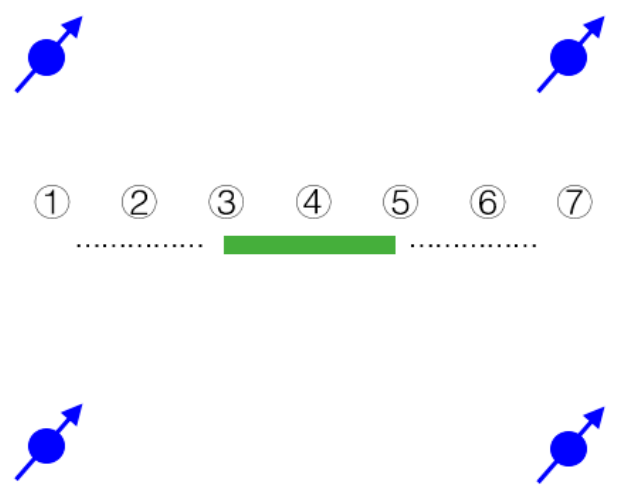
Figure 10. Mixed five-spot well pattern of vertical-injectors and horizontal producer ( ① – ⑦ show the code of different horizontal locations).